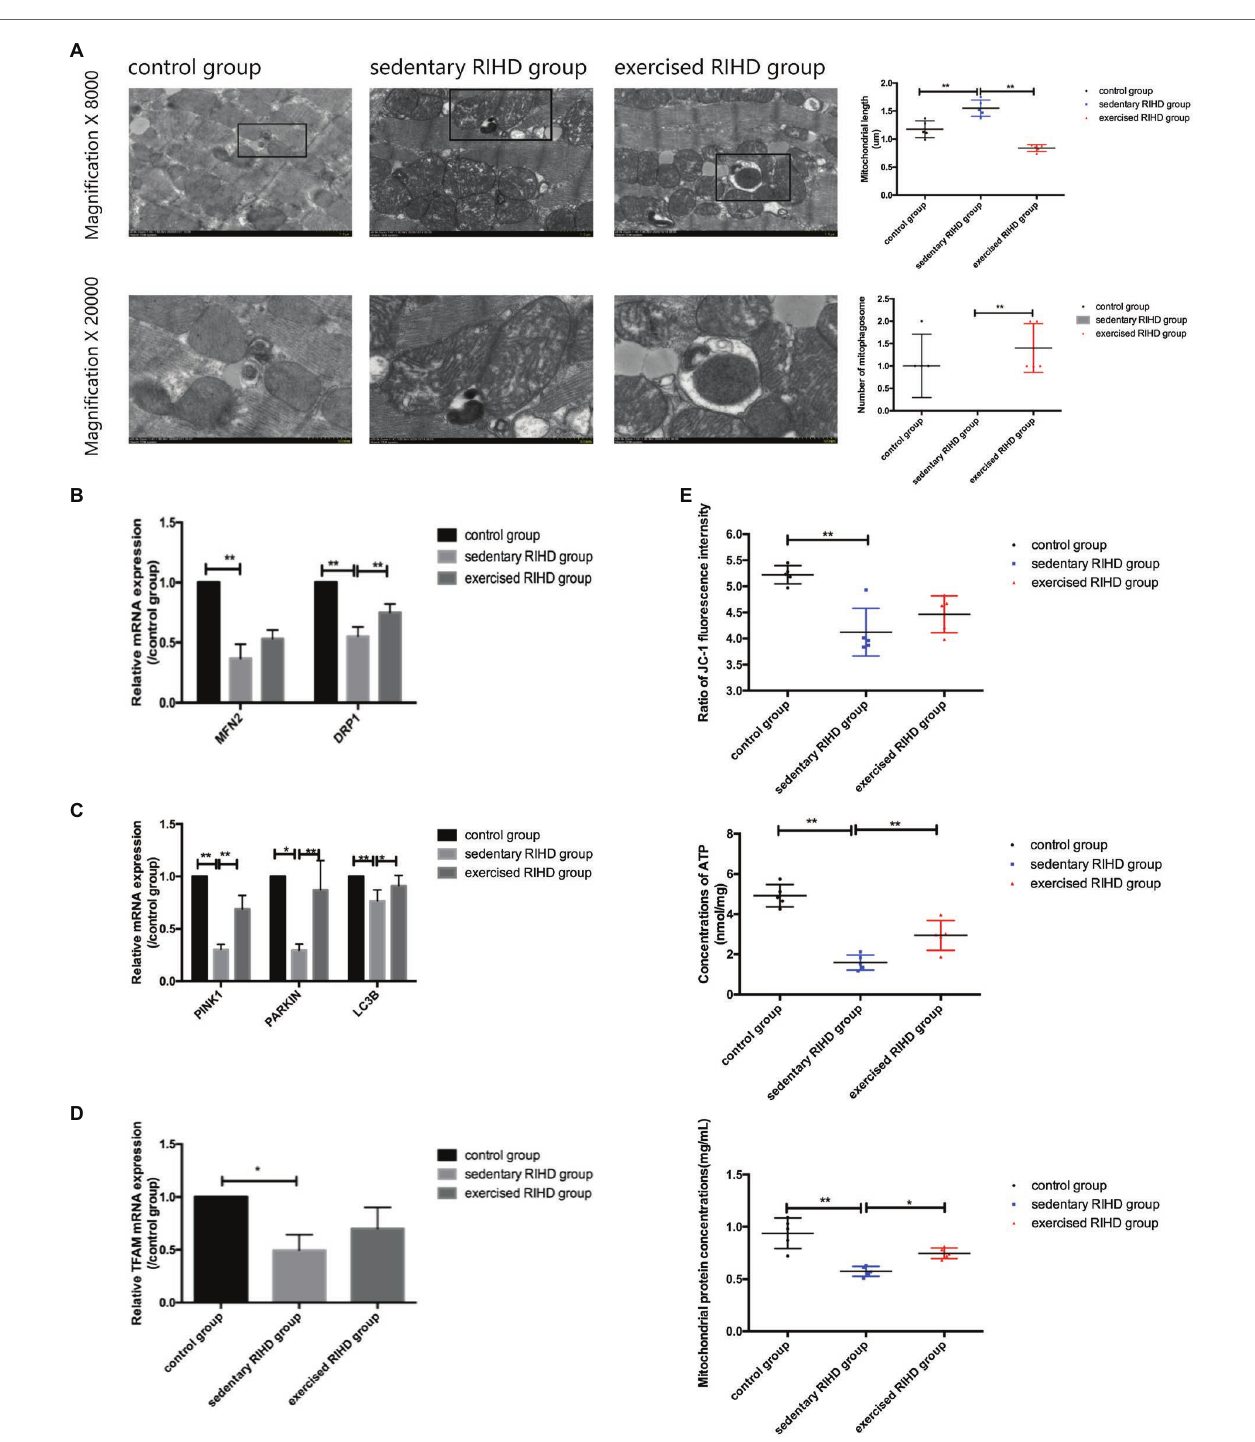
FIGURE 4 | The effect of exercise on mitochondrial function and mitochondrial turnover markers in cardiomyocytes in RIHD mice. (A) The formation of mitophagosomes (indicated by the black square) was observed in the control and exercised RIHD groups. The mitochondrial length and number of mitophagosomes were quantified via Image-Pro Plus 6.0 ( n = 3 samples/group). ANOVA was used to compare the mitochondrial length among groups, while the number of mitophagosomes was compared using the Mann–Whitney U test. (B) Comparison of the relative mRNA expression of mitochondrial dynamics among the groups. (C) Comparison of the relative mRNA expression of markers of mitophagy markers in the groups. (D) Comparison of the relative mRNA expression of a mitochondrial biogenesis marker among groups. (E) The effect of exercise on the mitochondrial function of cardiomyocytes after irradiation. ANOVA was used to compare the mitochondrial membrane potential ( ΔΨ m), ATP production, and mitochondrial protein concentrations among the groups ( n = 5 samples/group). * p < 0.05, ** p <